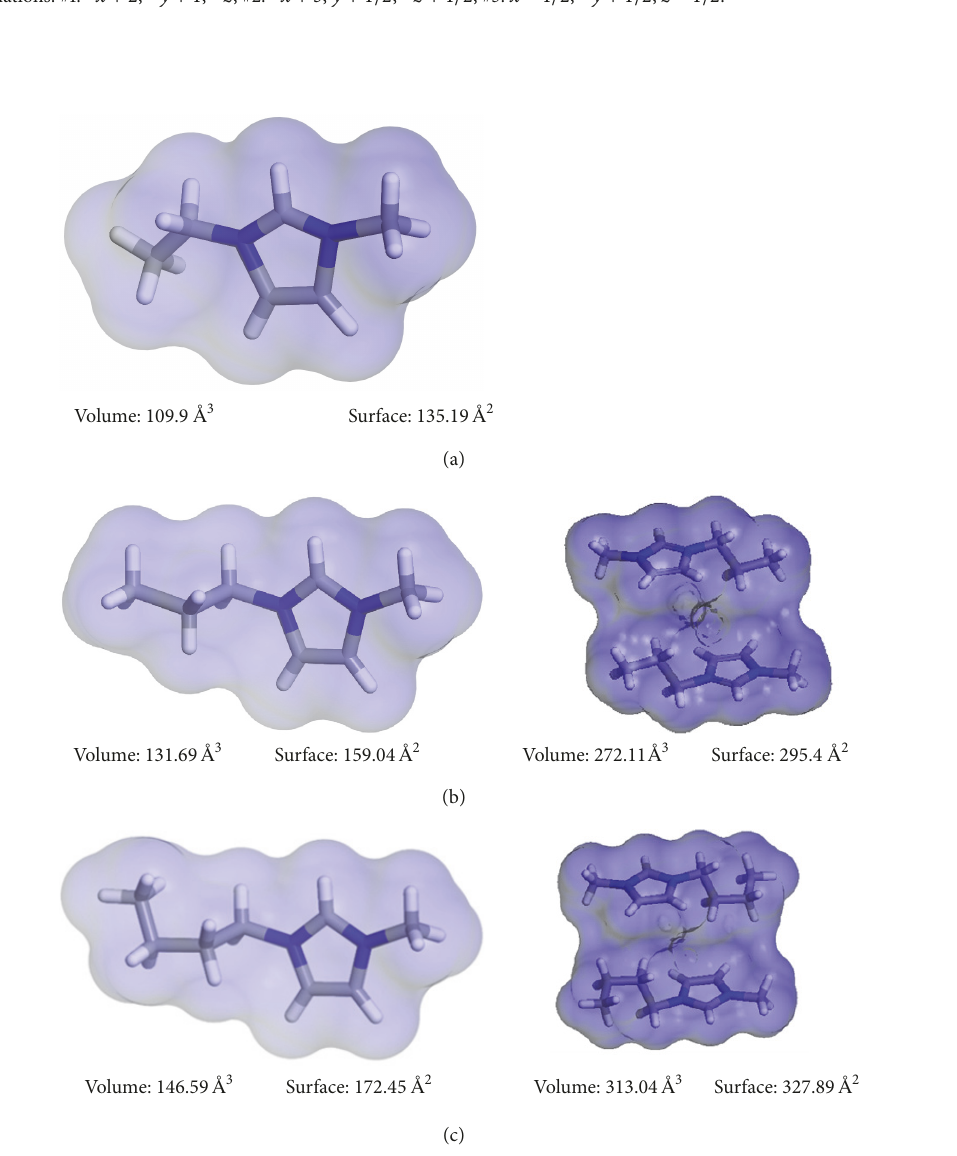
Figure 3: Connolly surfaces of the incorporated cations in their in situ conformations (left) and the cation pairs (right): (a) 1-ethyl- 3-methylimidazolium, with data borrowed from the isoreticular correspondent prepared with nickel in place of cobalt, (b) 1-propyl-3- methylimidazolium, and (c) 1-butyl-3-methylimidazolium [28]. (Volume and surface area values have been calculated with the grid interval of 0.15 ˚A and the Connolly radius being 1.0